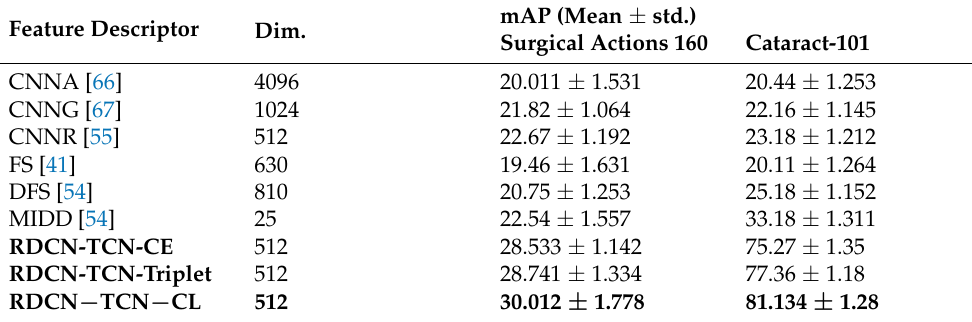
Table 6. Comparison with the state of the art on Surgical Actions